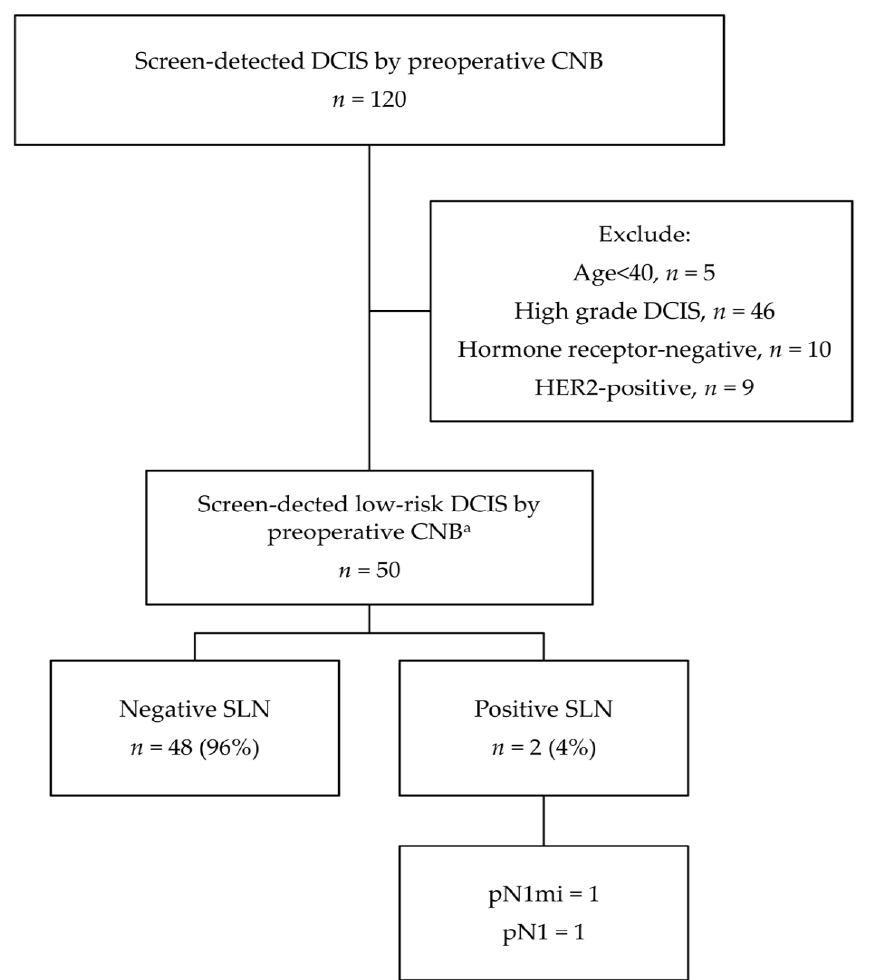
Figure 4. Results of sentinel lymph node biopsy among patients diagnosed with low-risk ductal carcionm in situ preoperatively. DCIS, ductal carcinoma in situ; CNB, core needle biopsy; HER2, human epidermal growth factor receptor 2; SLN, sentinel lymph node; pN1mi, micrometastasis; pN1, 1–3 macrometastasis. a The definition of low-risk DCIS is consistent with the inclusion criteria of the COMET(Comparison of Operative versus Monitoring and Endocrine Therapy) trial.